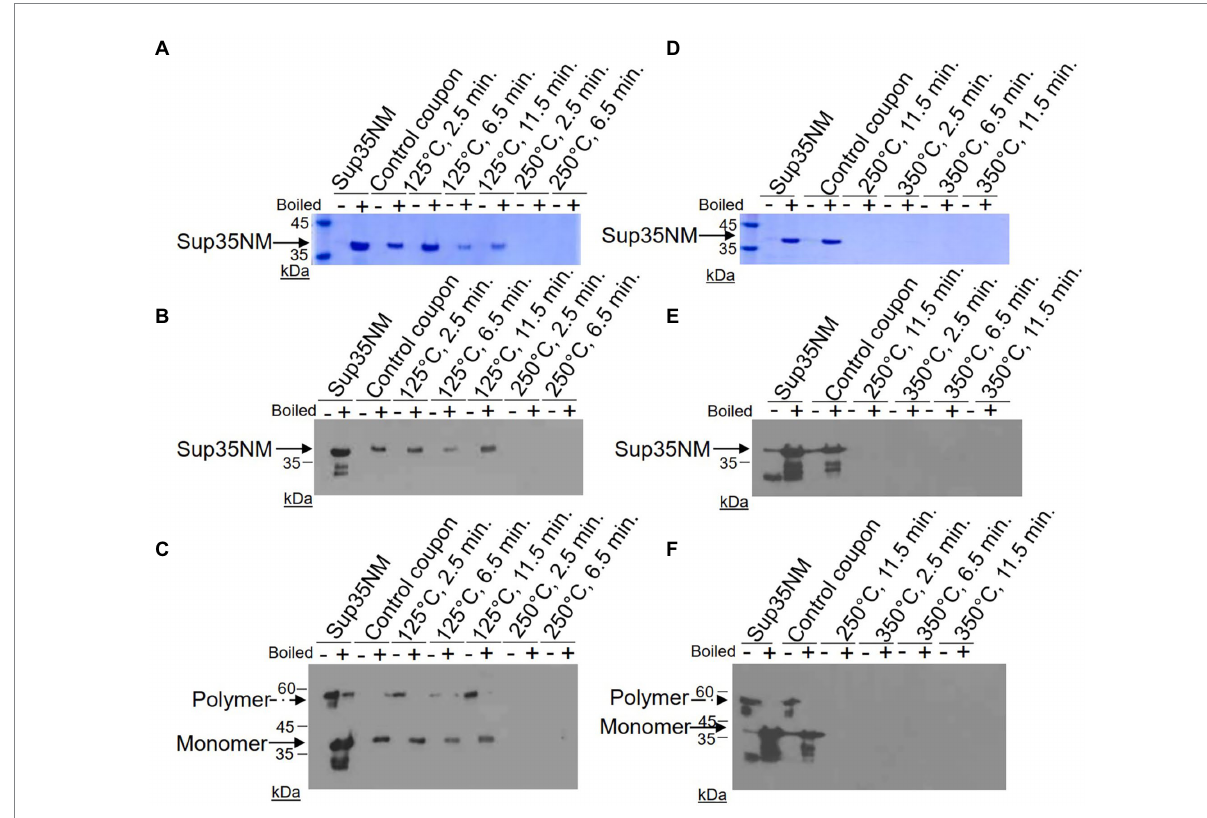
FIGURE 1 Detection of Sup35NM-His 6 aggregates recovered from stainless-steel coupons by SDS-PAGE and Western blotting. Proteins from control coupons, and from coupons treated at 125 ° C, 250 ° C and 350 ° C for various periods of time were analyzed as indicated. In vitro aggregated Sup35NM not immobilized on a coupon was used as a control. Amount of proteins loaded was normalized according to Bradford assay. (A,D) SDS-PAGE gels stained with Coomassie Blue. Samples were alternated in such a way that not-boiled samples ( − ) were loaded first, followed by pre-boiled samples (+). Aggregated protein cannot enter the gel without pre-boiling. Left lane contains molecular weight markers. (B,E) SDS-PAGE gels analyzed by Western blotting, followed by reaction to anti-His 6 antibodies. Sup35NM-Hi s6 monomer bands are indicated by the solid arrow. Lower bands likely represent proteolytic fragments. (C,F) Boiled SDS-PAGE gels analyzed by Western blotting, followed by reaction to anti-His 6 antibodies. Aggregated protein (polymer) in non-boiled samples enters the gel after the gel is boiled. Positions of polymers and monomers are shown by arrows. Lower bands likely represent proteolytic fragments. Gels analyzed by Western were overexposed in order to see even residual amounts of immunoreactive material. Positions of nearest molecular weight markers are indicated on Western gels.